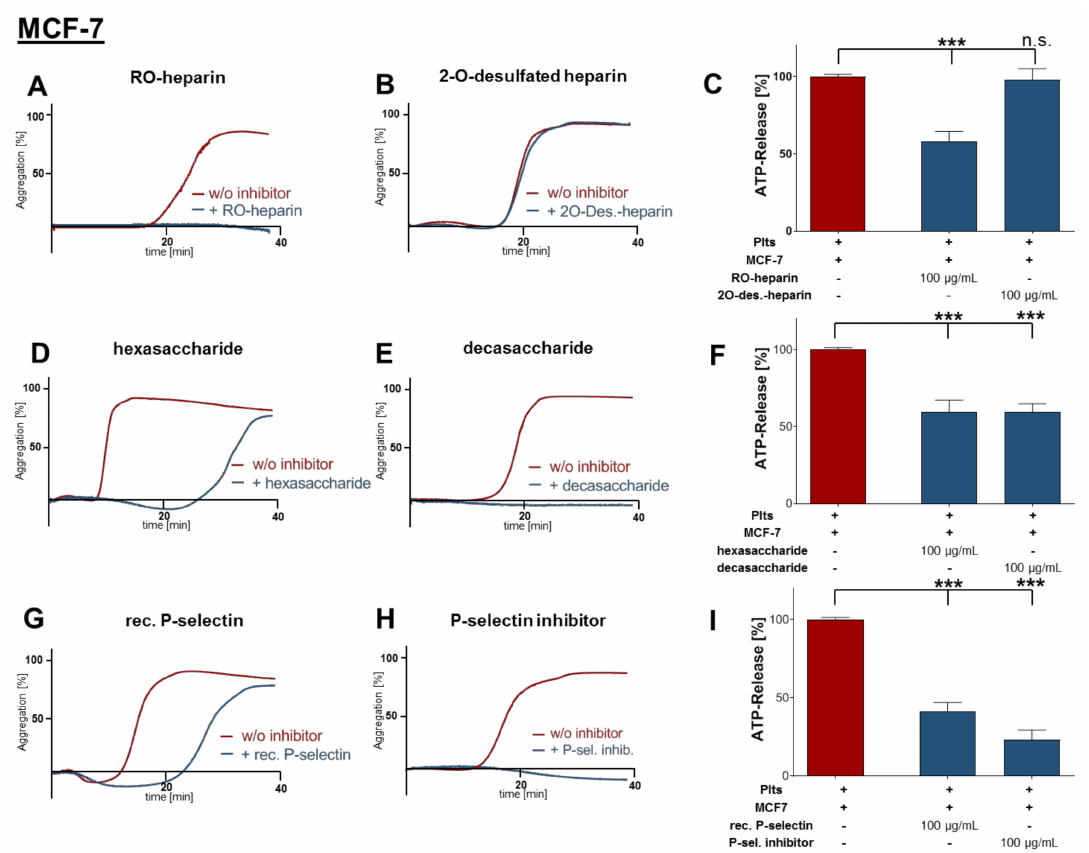
Figure 2. Impact of heparin derivatives on platelet aggregation and secretion. ( A , B ) Representative traces showing platelet-tumor cell aggregation in response to MCF-7 cells. Platelets were preincubated for 30 min with ( A ) 100 µ g / mL RO-heparin or ( B ) 100 µ g / mL 2- O -desulfated heparin; ( C ) quantification of ATP release from MCF-7 cell stimulated platelets preincubated with 100 µ g / mL RO-heparin or 100 µ g / mL 2- O -desulfated heparin; ( D , E ) representative traces showing platelet-tumor cell aggregation in response to MCF-7 cells, platelets were preincubated with ( D ) 100 µ g / mL hexasaccharide or ( E ) 100 µ g / mL decasaccharide ( n = 5); ( F ) quantification of ATP release from MCF-7 cell stimulated